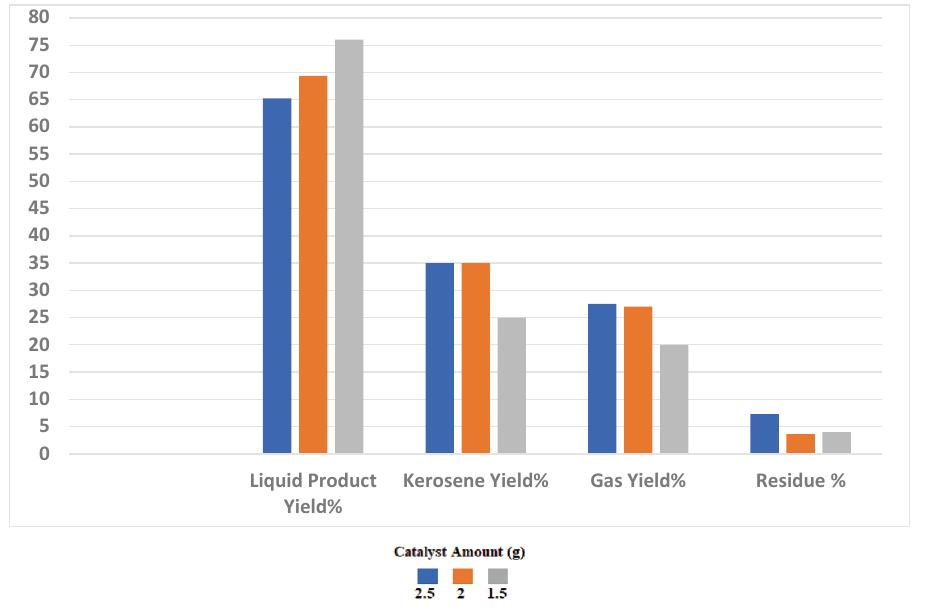
Figure 9. Distribution of the products from the cracking of WCO at 450 °C on the ZnCoAl 2 O 4 nano catalyst with wt. %: 2.5,2 and 1.5.